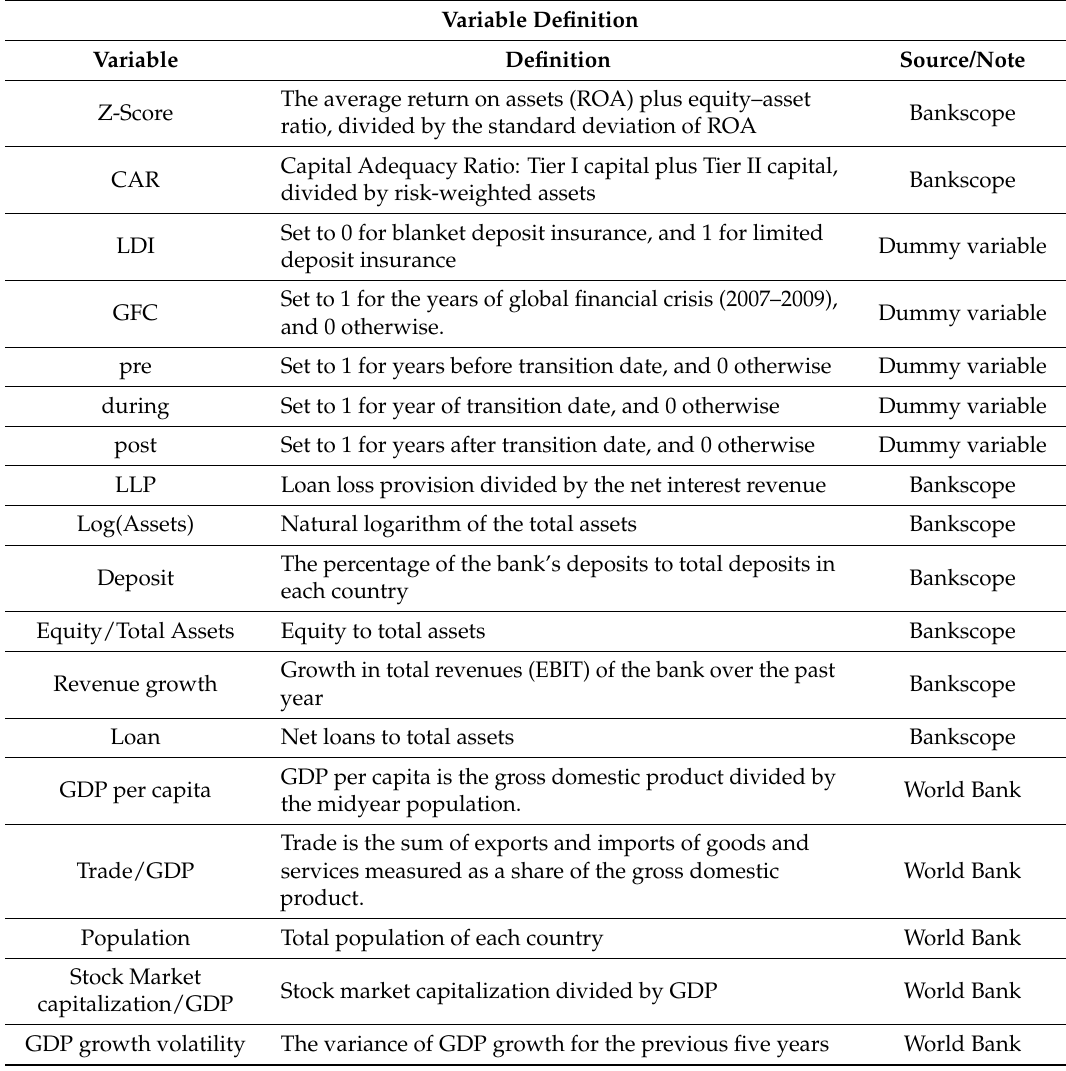
Table A1. Variable